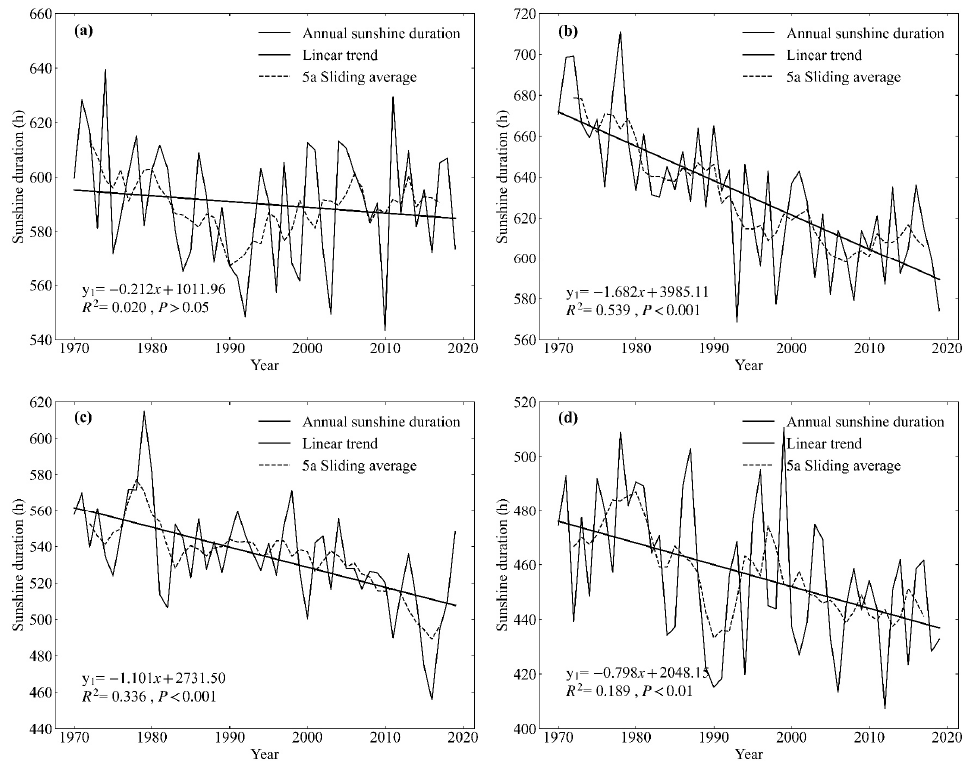
Figure 2. Variations of SD in ( a ) Spring, ( b ) Summer, ( c ) Autumn and ( d ) Winter.